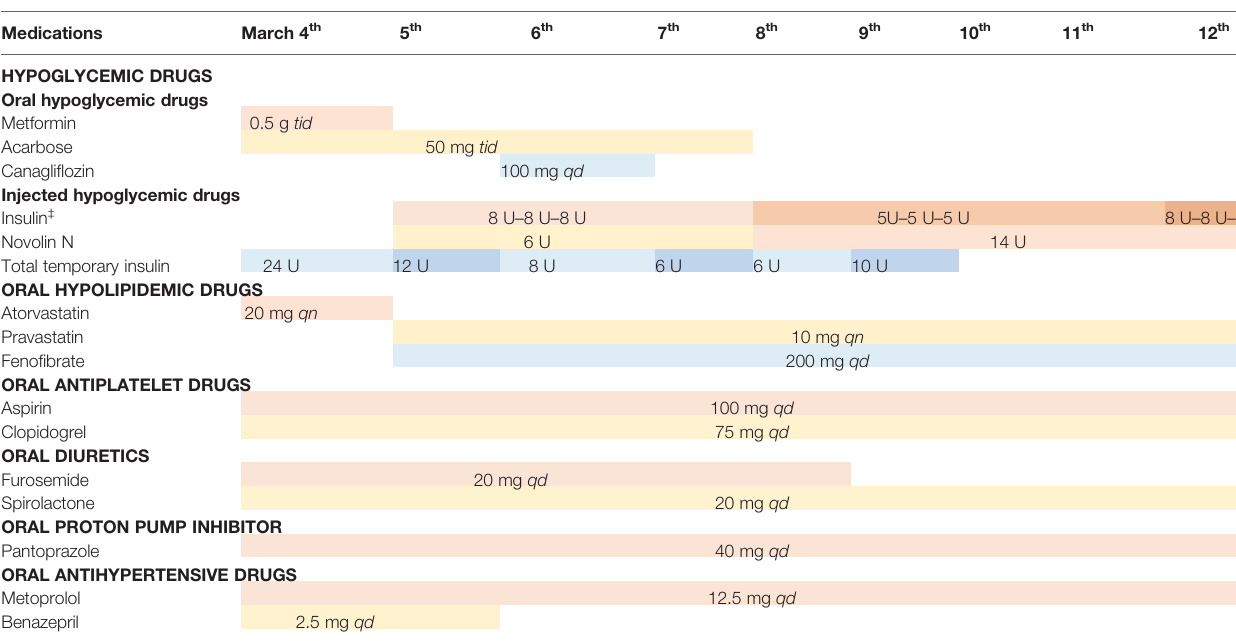
TABLE 2 | Main medications information and history.